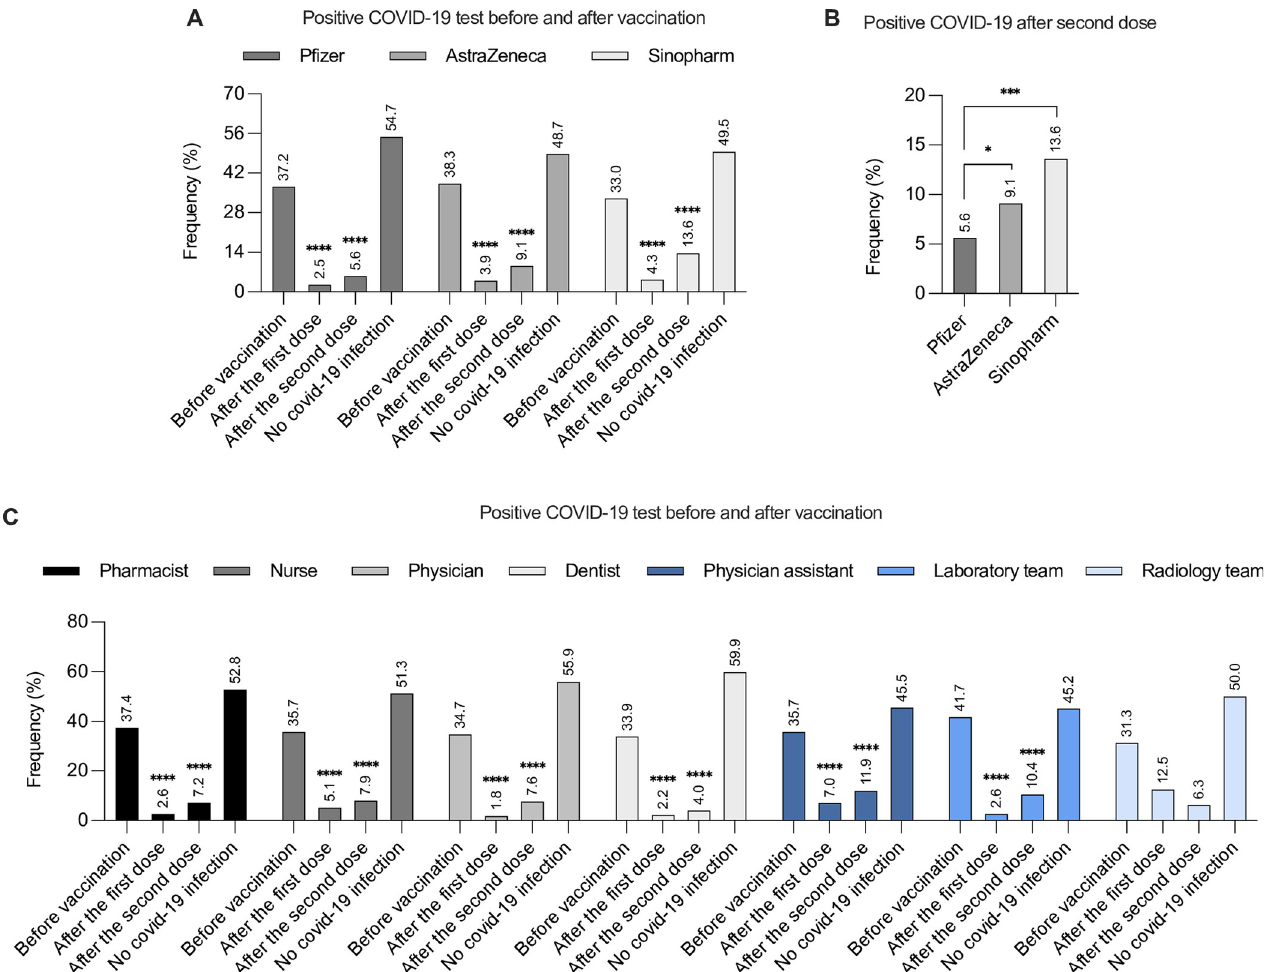
Fig 5. Prevalence of the COVID-19 infection (percentage) before and after vaccination. (A) prevalence of COVID-19 infection before, after one dose and after two doses of the Pfizer, AstraZeneca, and Sinopharm vaccines, (B) Prevalence of the COVID-19 infection after two doses of the Pfizer, AstraZeneca, and Sinopharm vaccines, (C) Prevalence of the COVID-19 infection among healthcare professionals before, after one dose and after two doses of the vaccines. A statistical analysis of the COVID-19 infection among vaccinated participants who received various vaccine types, (A) after the first dose and the second dose versus before vaccination, (B) after the second dose between various vaccine types or (C) among healthcare professionals, was performed using the chi-squared test. ���� p <